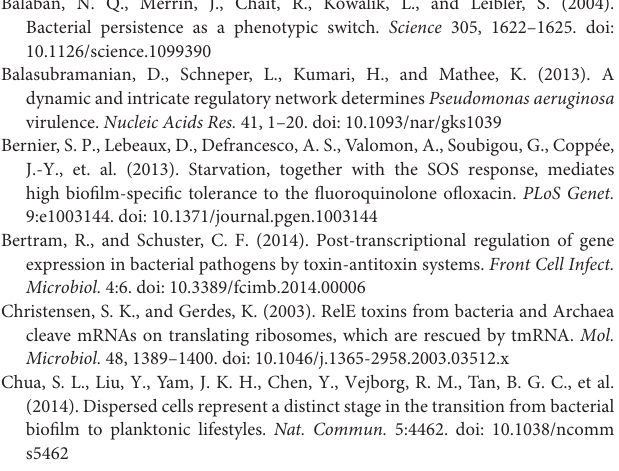
Figure S4 | Fluorescence microscopy of 1 higB mutant containing P higB -gfp . At an OD 600 of 0.3, a 1 higB mutant containing P higB -gfp were incubated with 0.025 µ g/ml ciprofloxacin for 2h and then treated with 0.125 µ g/ml ciprofloxacin for 30min in LB. The ciprofloxacin treated and untreated bacteria were collected and washed with PBS twice. The bacterial cells were stained with PI (A) or immunostained with rabbit anti-PcrV followed by Alex Fluor 594–labeled goat anti–rabbit immunoglobulin (B) . Bar = 10 µ m. Figure S5 | Fluorescence microscopy of 1 higB 1 higA mutant containing P